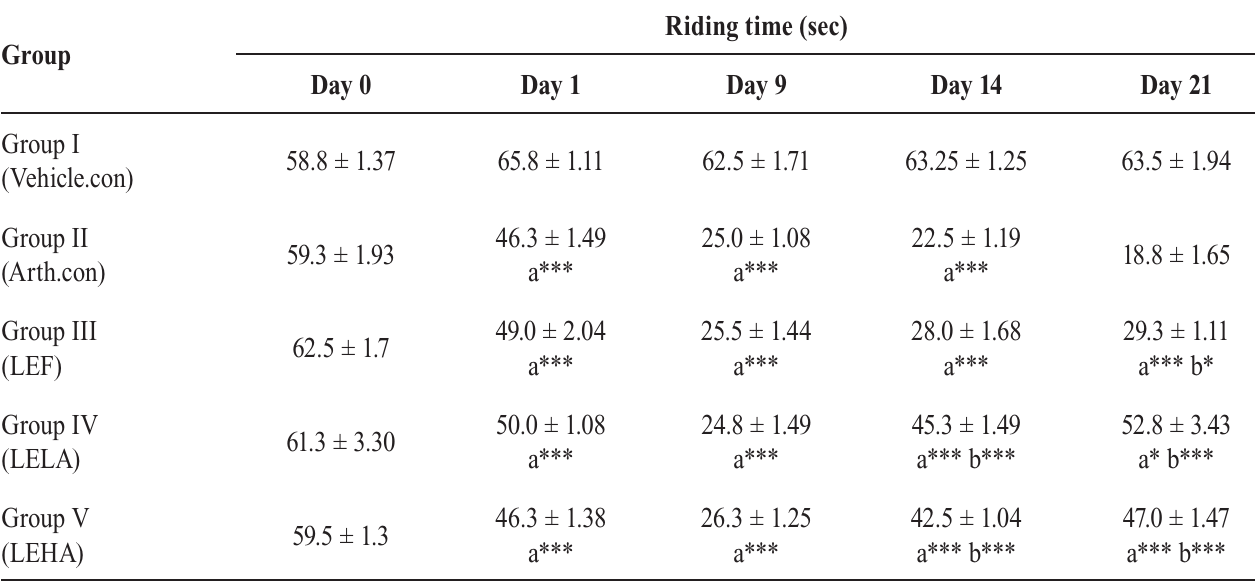
TABLE VII- Effect of leflunomide and amitriptyline on neuromuscular coordination in FCA induced arthritic rats